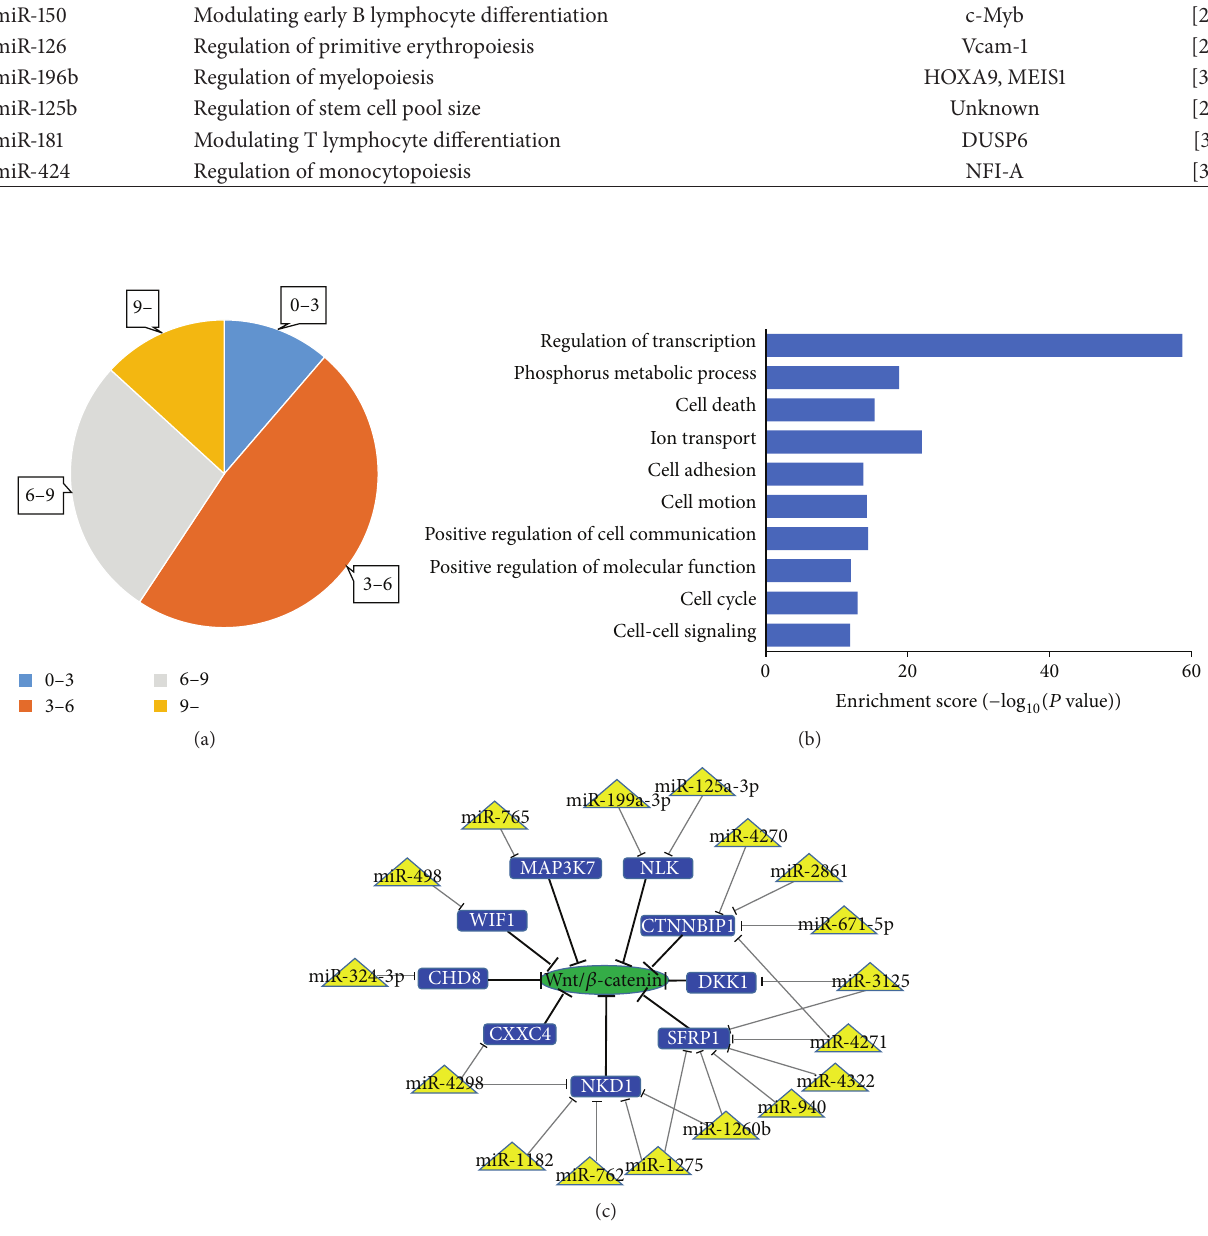
Figure 2: Bioinformatic analyses of miRNAs in MSC-MVs. (a) The overall expression level of miRNAs in MSC-MVs. (b) Gene Ontology enrichment analysis of the potential targets of expressed miRNAs in MSC-MVs. (c) A schematic illustration representing miRNAs and potential targets involved in regulation of the Wnt/ 𝛽 -catenin pathway. Blue rectangles: genes that are reported to inhibit the Wnt/ 𝛽 -catenin pathway and are expressed in CB-derived HSCs. Yellow triangles: relatively highly expressed miRNAs in MSC-MVs. Green ellipses: Wnt/ 𝛽 - catenin pathway. Black and gray lines indicate inhibitory